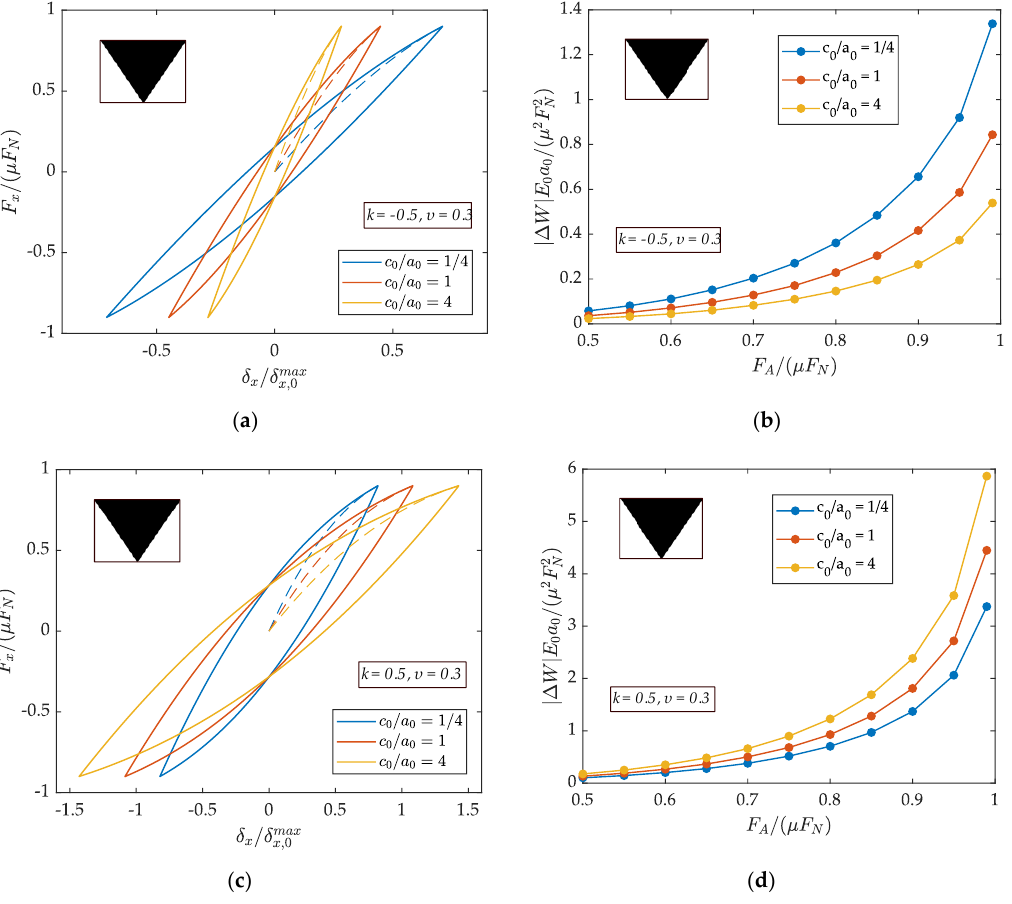
Figure 8. Hysteresis curve and energy dissipation of a conical indenter for a fixed elastic inhomogeneity 𝑘 and various quotients of the characteristic depth 𝑐 0 /𝑎 0 : ( a ) Tangential force over the tangential displacement for 𝑘 = −0.5 ; ( b ) Energy dissipation over the traction ratio 𝐹 𝐴 for 𝑘 = −0.5 ; 𝜇𝐹 𝑁 ( c ) Tangential force over the tangential displacement for 𝑘 = 0.5 ; ( d ) Energy dissipation over the traction ratio 𝐹 𝐴 for 𝑘 = 0.5 . 𝜇𝐹 𝑁